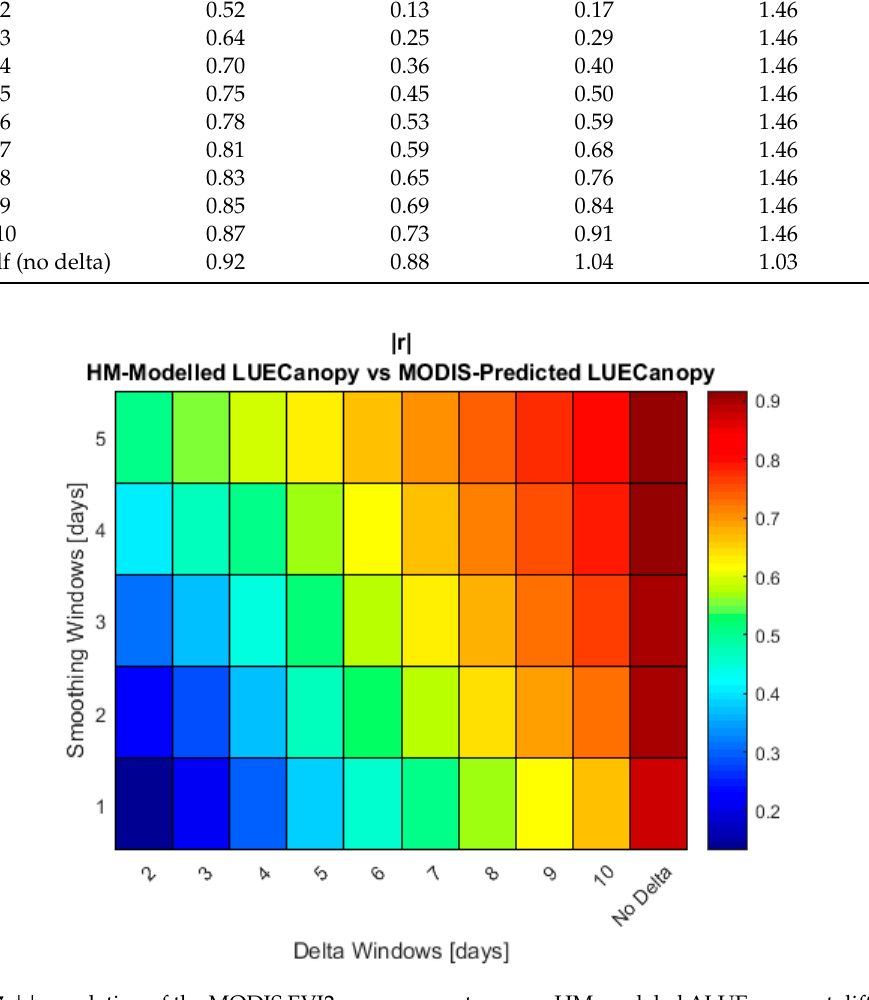
Figure 7. | r | correlation of the MODIS EVI2 measurements versus HM modeled ∆ LUE Canopy at di ff erent Figure 7. |r| correlation of the MODIS EVI2 measurements versus HM modeled Δ LUE Canopy at levels of smoothing and values of ∆ . N = different levels of smoothing and values of Δ . N = 2359.